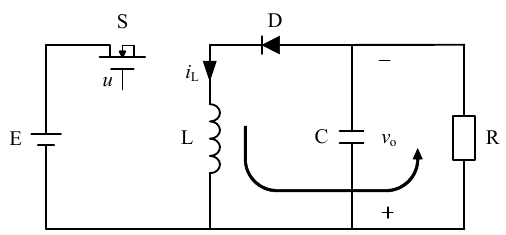
Figure 3. The equivalent circuit of the buck-boost converter when u = 0.